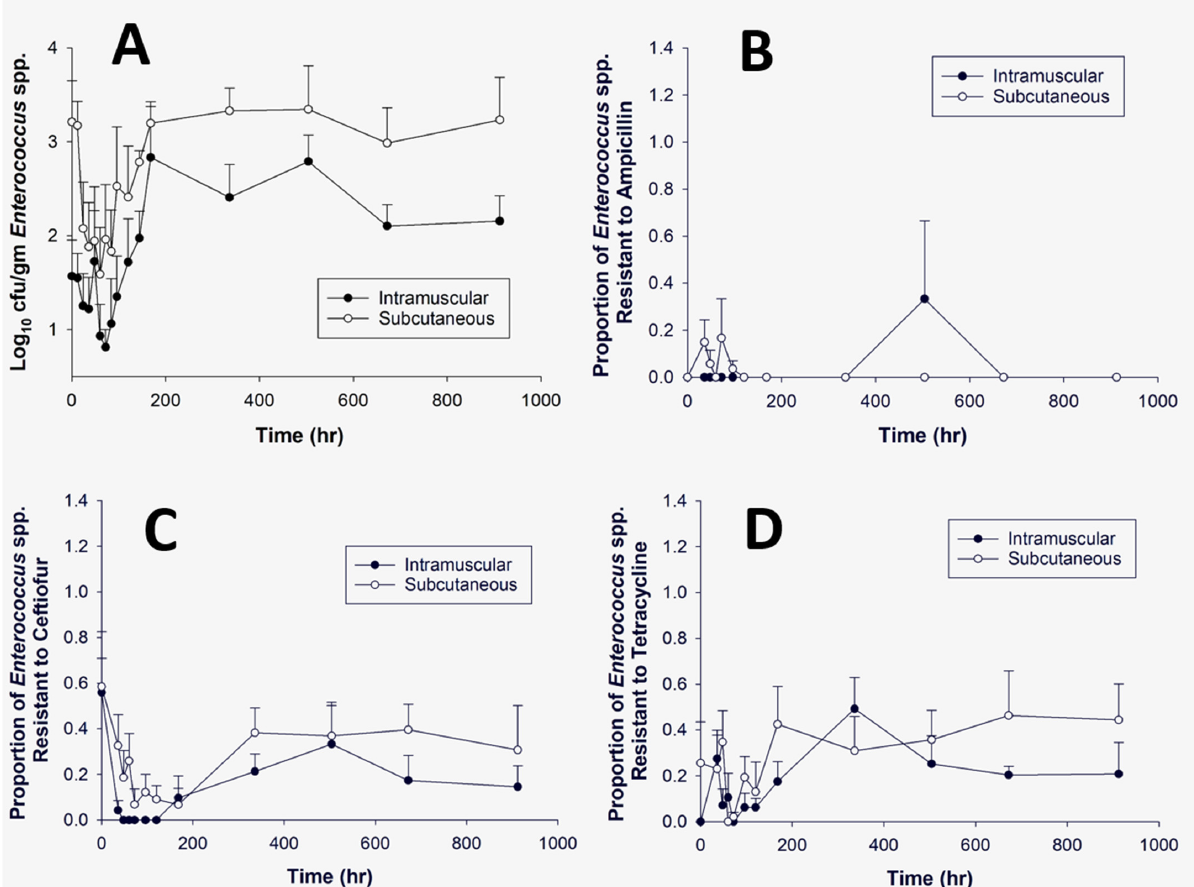
Figure 5. This panel represents Enterococcus isolates grown over time on no antibiotic ( A ), ampicillin (16 µg/mL) ( B ), ceftiofur (8 µg/mL) ( C ), or tetracycline (16 µg/mL) ( D ). The dark circle presents the intramuscular dosing group and the open circle represents the subcutaneous dosing group over a 912-h time period. Panel A demonstrates the log 10 CFU/g of Enterococcus . Panels B–D show the proportion of Enterococcus demonstrating phenotypic resistance based on human breakpoints. Bars represent the standard error of the mean. There were no significant differences noted for each dosing group per plain and antibiotic infused plate at the predetermined time points. Table 4. Predetermined Student’s T tests to observe significant differences at particular time points for E. coli isolates grown with or without antibiotics. There were no significant differences noted for any of the above comparisons.